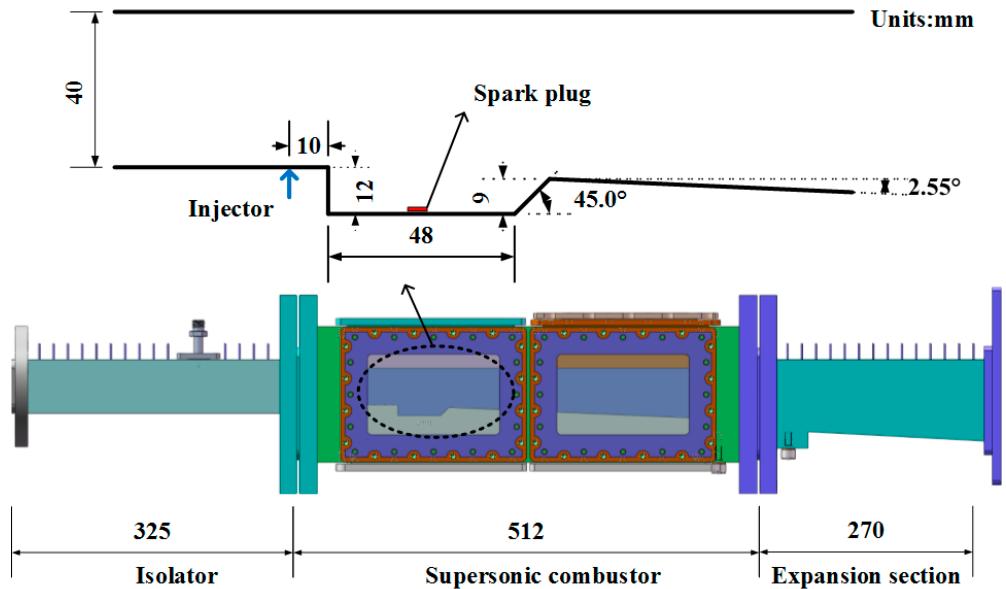
Figure 1. Configuration of the supersonic combustion test device and the combustor. The length, width, and height of the combustor were 512, 40, and 50 mm respectively. The top wall and the bottom wall upstream of the cavity were both horizontal. The rear- wall diverged at a constant angle of 2.55 ◦ . The cavity with a depth of 12 mm and a